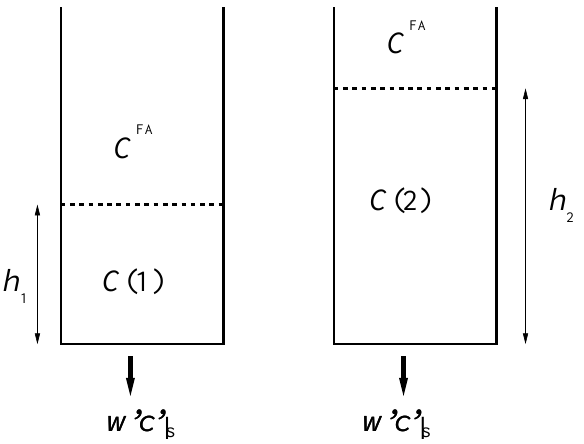
Fig.1. Sketch ofthe evolution ofthe bulkCO 2 mixing ratioquantity by using the integralfromof themixed-layer equations. The growth Fig. 1. Sketch of the evolution of the bulk CO 2 mixing ratio quan- oftheboundary layerfrom h 1 to h 2 depends ontheheatandmoisturebudgets. NoticethatweareassuminganegativefluxforCO 2 thatis characteristicoftheassimilationbyplantsduringdaytimeandonlyverticalexchangeprocessesaretakenintoaccount. tity by using the integral from of the mixed-layer equations. The growth of the boundary layer from h 1 to h 2 depends on the heat and moisture budgets. Notice that we are assuming a negative flux for CO 2 that is characteristic of the assimilation by plants during day- time and only vertical exchange processes are taken into